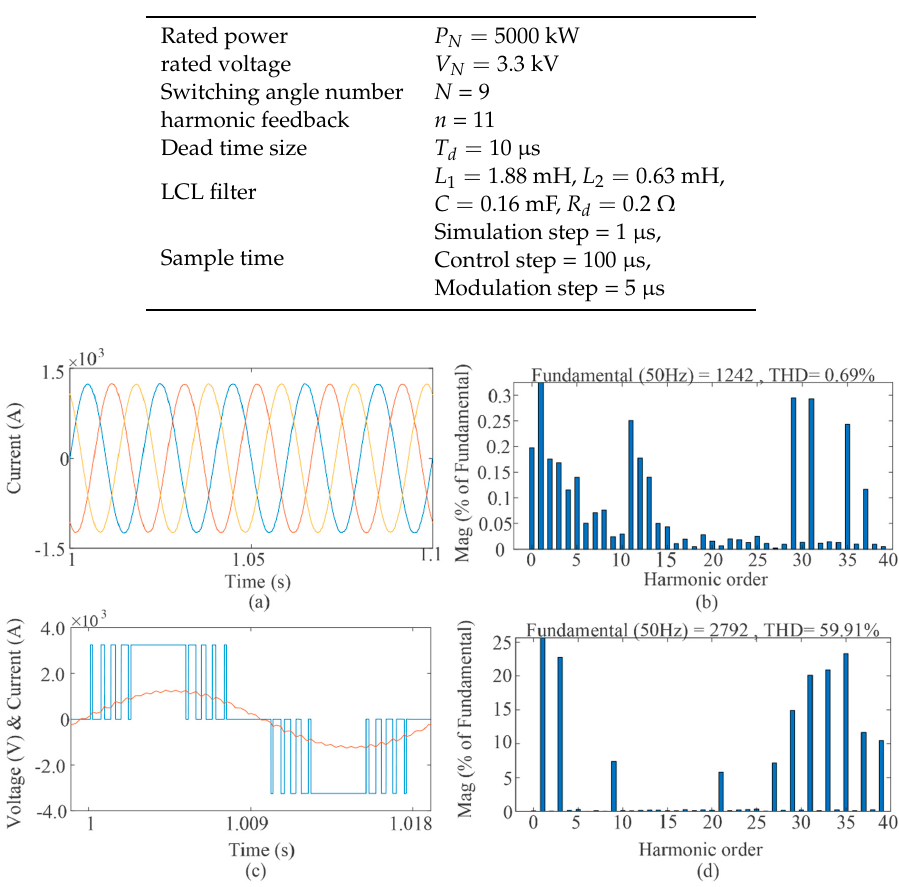
Figure 17. Line currents ( a ), the THD analysis of phase A current ( b ), detailed bridge arm voltage and current ( c ), and the THD analysis of the bridge arm voltage ( d ), under ideal SHE-PWM modulation.